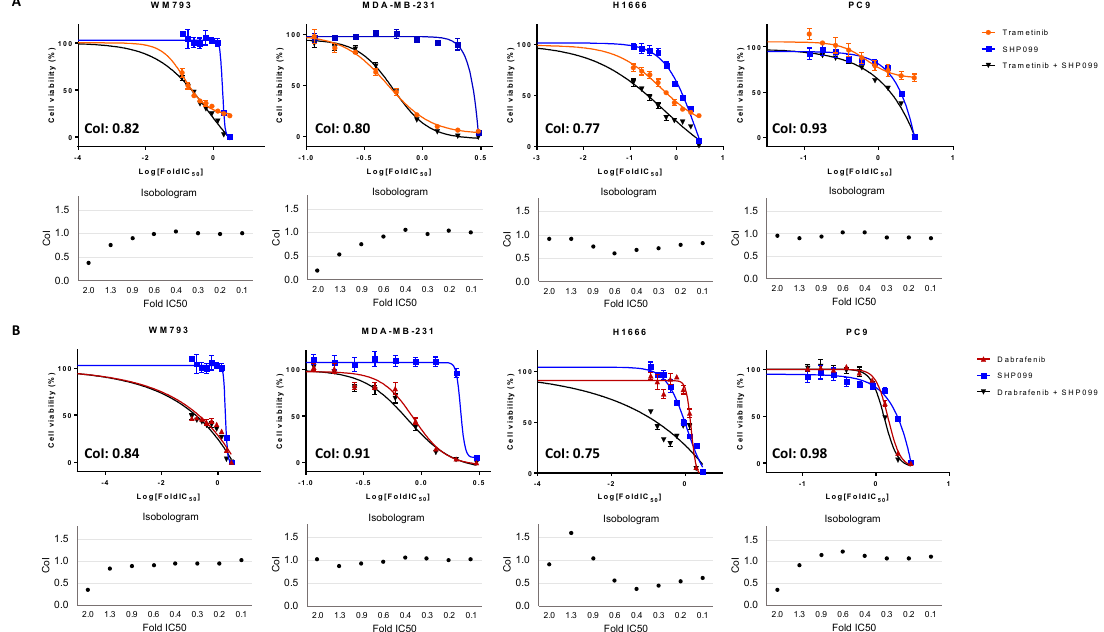
Figure 4. MTT cell viability assays were performed in the class I (WM793), class II (MDA-MB-231), and class III (H1666) BRAF -mutant cell lines and one BRAF WT cell line (PC9), to compare the e ff ect of single MEK (trametinib) and single SHP099, or combined treatment on cell viability ( A ) and to compare the e ff ect of single BRAF (dabrafenib) and single SHP099, or combined treatment on cell viability ( B ). Isobolograms depict combination index (CoI) values at each drug concentration, calculated based on the Chou and Talalay method. Average CoIs are depicted in the graph, and CoI values < 1, = 1, and > 1 indicate synergism, additive e ff ect, and antagonism, respectively. Experiments were performed in biological triplicates with similar results, and representative graphs are shown.